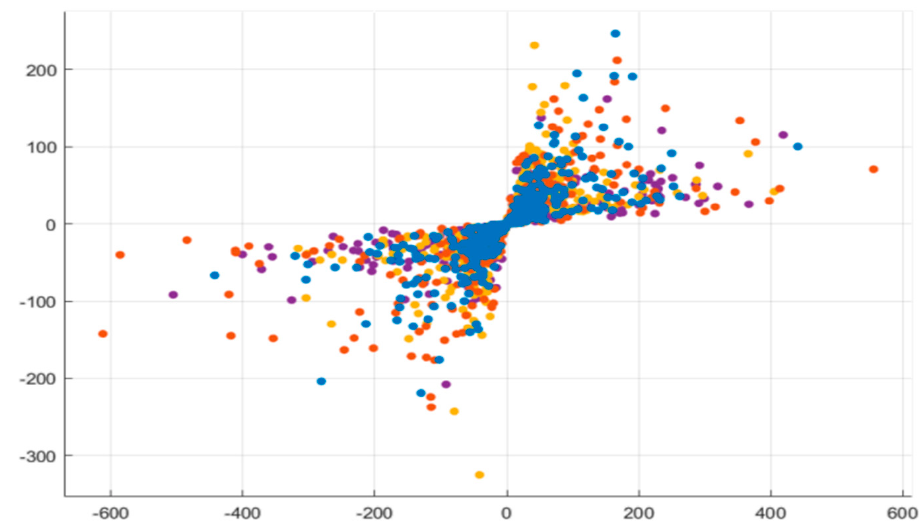
Figure 9. Data distribution of emotions in the arousal-valence plane. (Blue dots indicate LANV; red dots refer LAPV; yellow dots indicate HANV; and purple dots show HAPV emotions).